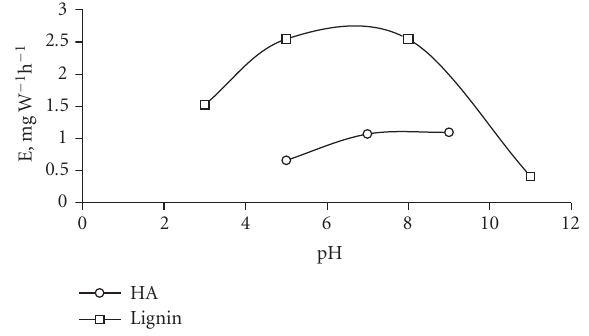
Figure 2: The dependence of the photocatalytic oxidation e ffi ciency E of humic acids and lignin on pH: initial concentration of humic acids 10 and lignin 100 mg L − 1 , buoyant catalyst plane surface con- centration 25g m − 2 ; treatment time